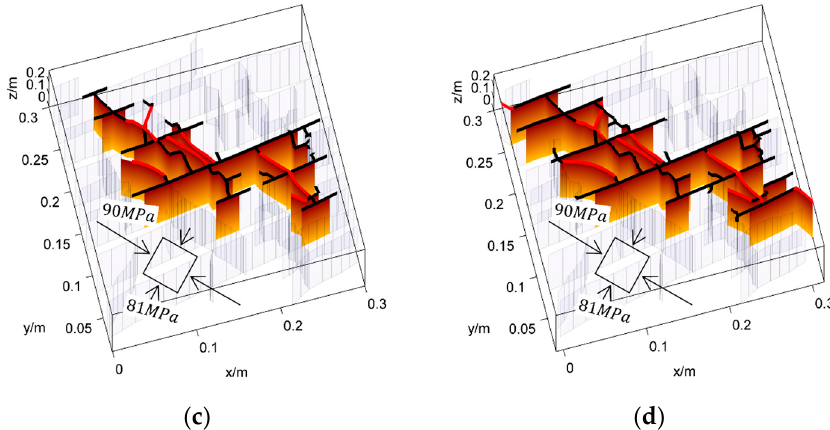
Figure 9. The propagation processes of the hydraulic fractures when the far field stress is σ max = 90 MPa, σ min = 81 MPa. The tensile mode fractures that are affected by fluid pressure are represented by the colored faces. The shearing fractures are marked by the bold black curves at top. The newly formed hydraulic fractures are marked by the bold red curves at top. The unaffected fractures are represented by the light mesh.